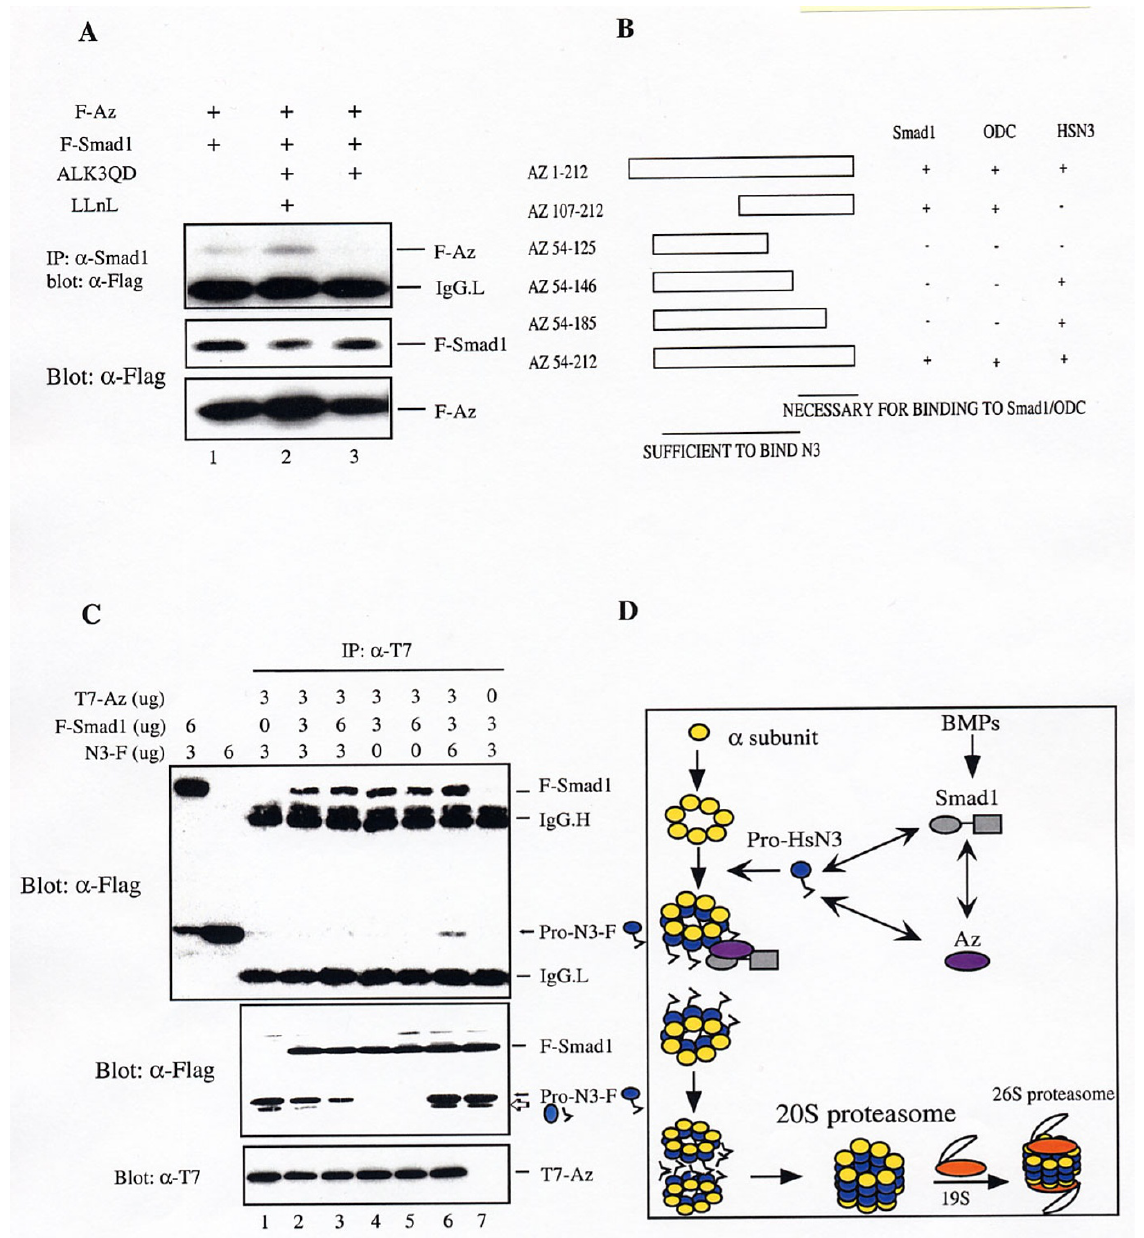
Figure 5 The formation of a ternary complex between Smad1, Az and HsN3.A. Az interacts with Smad1 and the interaction is enhanced by receptor activation in the presence of lactacystin. COS cells were transfected with the indicated plasmids. F- Smad1 was precipitated with anti-Smad1 monoclonal antibody and the co-precipitated F-Az was detected by anti-Flag Western blot. "IgG.L." represents the IgG light chain. The total expression of the proteins in the lysates was detected by Western blot as shown in the bottom panels. B. Results of domain mapping analyses of Az. Different deletion constructs of Az were made as illustrated and subcloned into yeast expression vector pJG4-5, which were then co-transformed with full length LexA-Smad1 and LexA-HsN3 into yeast two-hybrid system. The interaction tests were carried out similarly as shown in Fig. 1. The separate domains important for Az to bind HsN3 and Smad1 are indicated. C. Az interacts with both Smad1 and HsN3 when they are co-expressed at a specific ratio. COS1 cells were co-transfected with the indicated constructs of Smad1, Az and HsN3. The amount of DNA used for the transfection is also indicated. The co-precipitated Smad1 and Pro-N3-F are marked. D. A car- toon to summarize the observed complex formation between Smad1, HsN3 and Az along the proteasome assembly